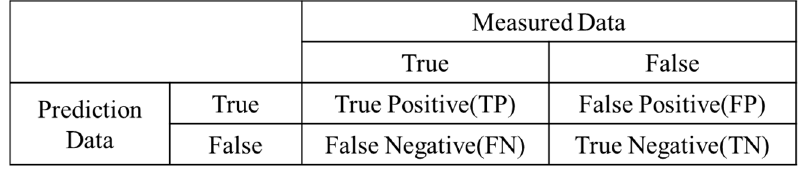
Figure 3. Confusion matrix (TP, FP, FN, and TN).